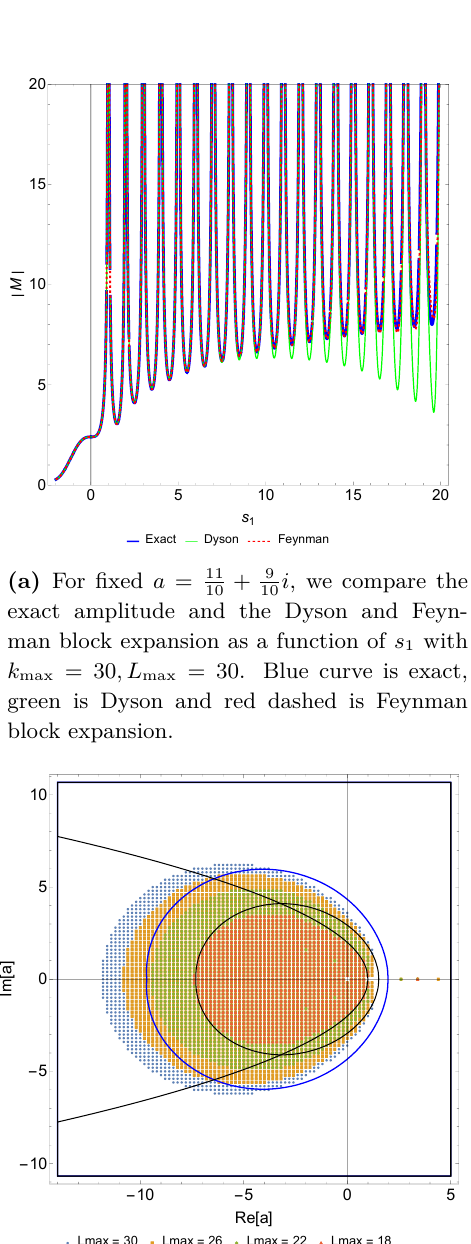
Figure 5. Numerical illustrations using string